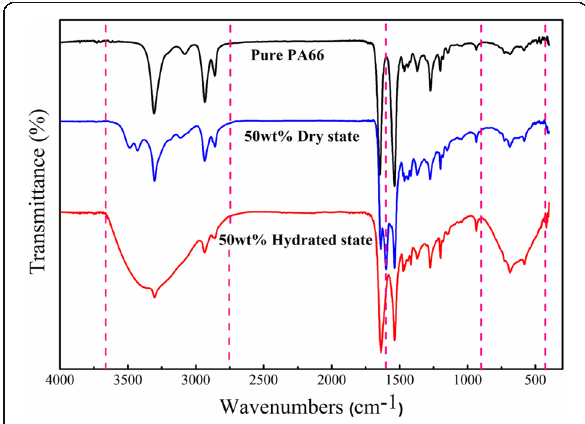
Fig. 7 FT-IR spectra of pure PA66 NFM and PA66/CoCl 2 ·6H 2 O (50 wt%) NFM in dry and hydrated